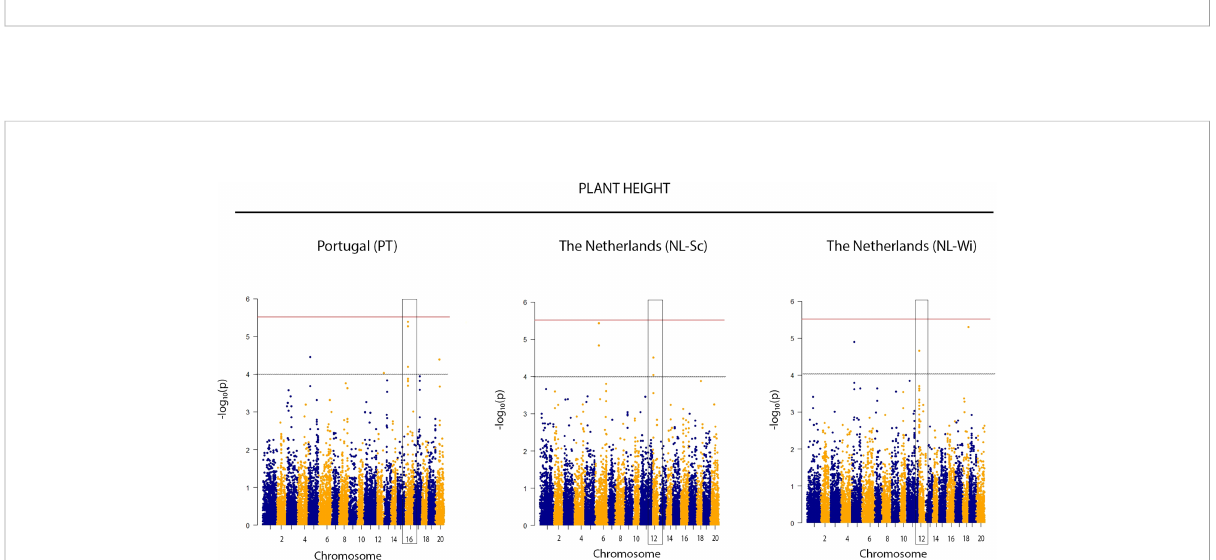
FIGURE 4 Manhattan plots suggestive of a SNP markers-trait association for plant height on chromosome LG16 and LG12, respectively for L. mutabilis growing in Mediterranean (Portugal) and North-Central European cropping conditions (NL-Sc and NL-Wi). The red line indicates the Bonferroni threshold (LOD = 5.52). The black dotted line indicates a suggestive threshold of LOD= 4. The rectangles highlight interesting piling up of SNPs below the threshold of signi fi cance, harboring interesting candidate genes related to plant